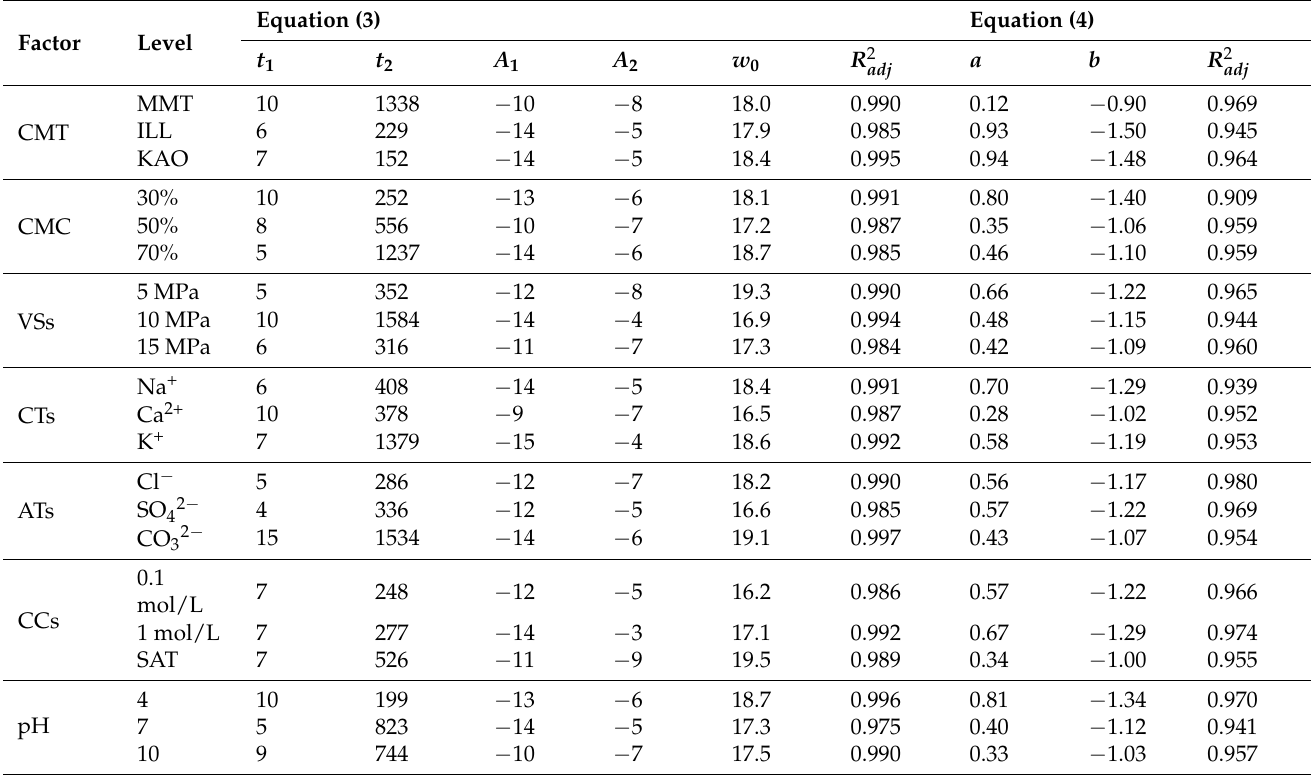
Table 2. Fitting results of water content and water absorption velocity changes with time for different factors at different